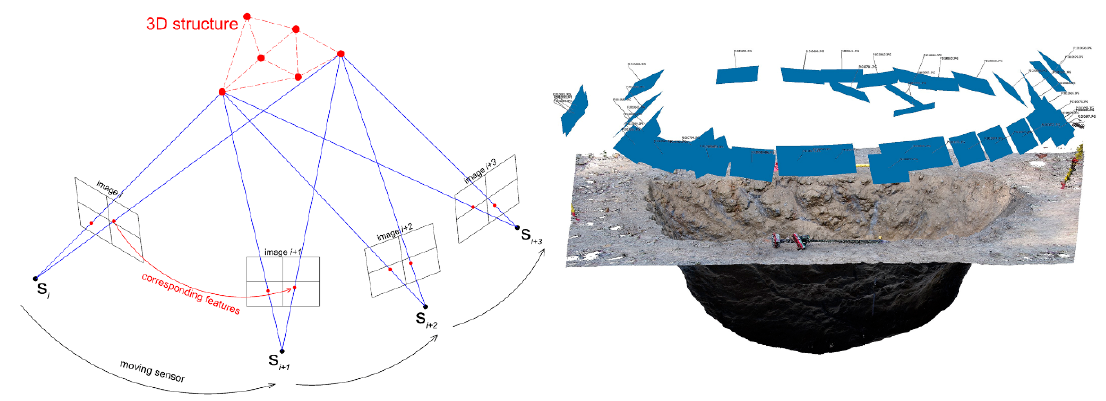
Figure 10. left—the principle of the SfM photogrammetric method (after [34]); right—imaging stations for SfM processing in the case study.